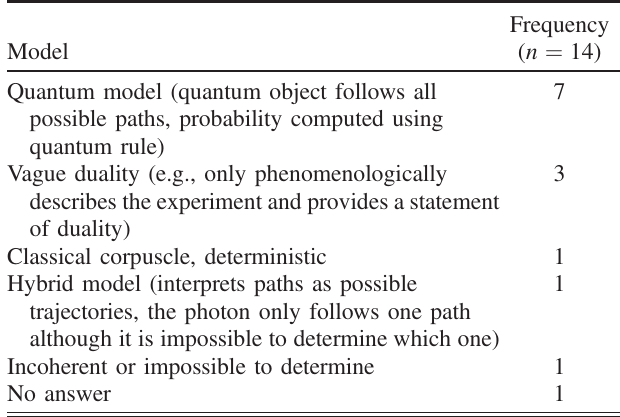
TABLE IV. Principal idea used by students in the answer to T2 (the photon and Mach-Zehnder interferometer).